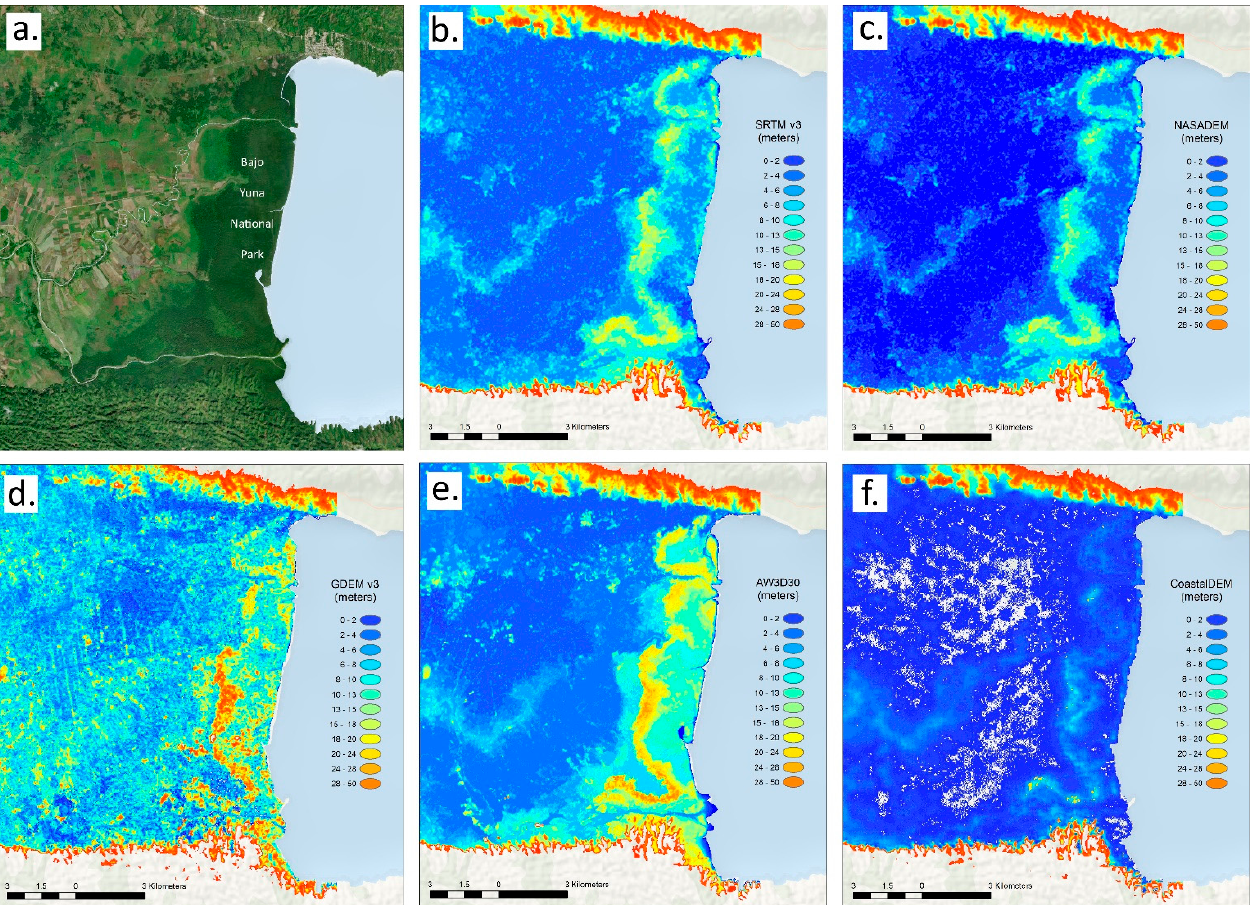
Figure 4. Comparison of 30 m global elevation products of Bajo Yuna National Park in the Dominican Republic which has a dense band of tall mangroves along the edge of Samaná Bay. Each product shows the relative impact that dense vegetation can have on the resulting surface elevation and the attempts to remove the vegetation to arrive at a ‘bare earth’ product. ( a ) satellite image showing the Bajo Yuna National Park and mangrove area; ( b ) SRTM v3; ( c ) NASADEM; ( d ) GDEM v3; ( e ) AW3D30; and ( f ) CoastalDEM. The highest mangrove canopy with the least amount of vegetation removed is in the photogrammetry-based GDEM from ASTER stereo imagery and the AW3D radar-derived products. The CoastalDEM shows the vegetations largely removed to arrive at a more suitable ‘bare earth’ product for SLR and storm surge modeling.